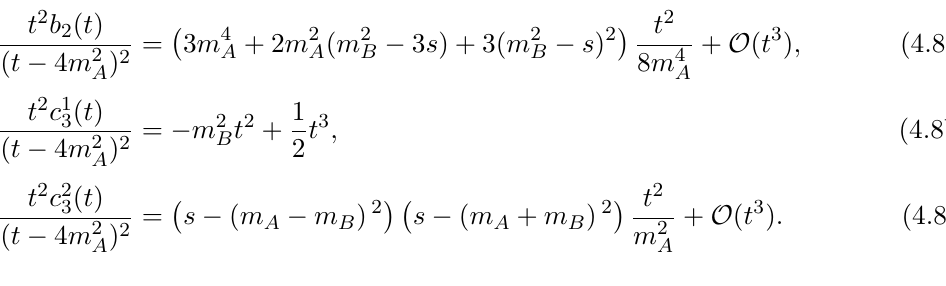
Figure 4 . LS Triangle